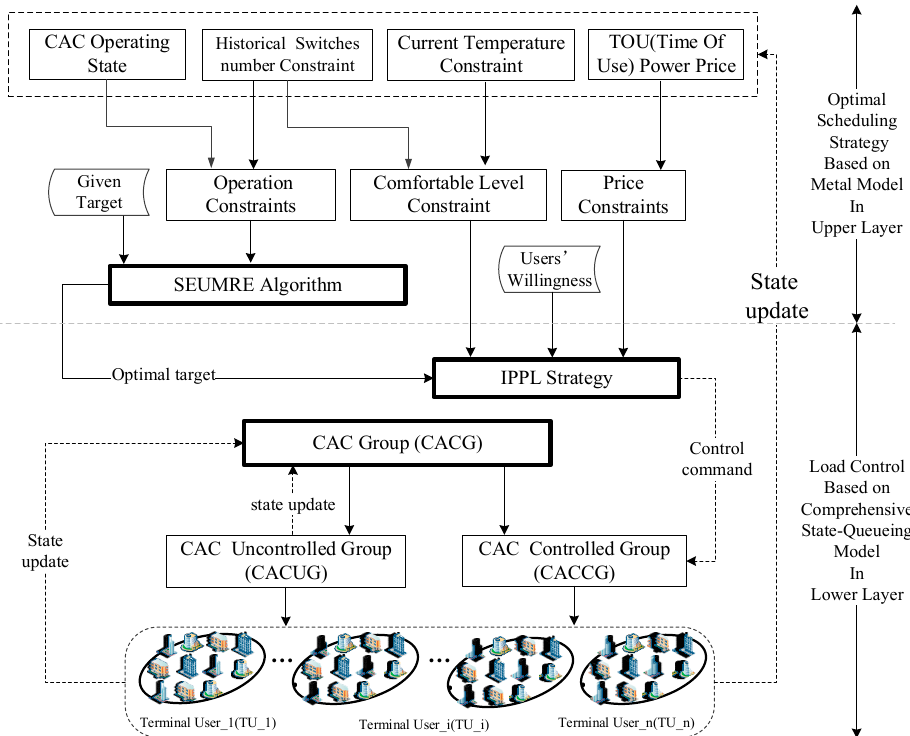
Figure 1. Optimal Coordinated framework Space Exploration and Unimodal Region Elimination (SEUMRE) and integrated parameter priority list (IPPL) method.